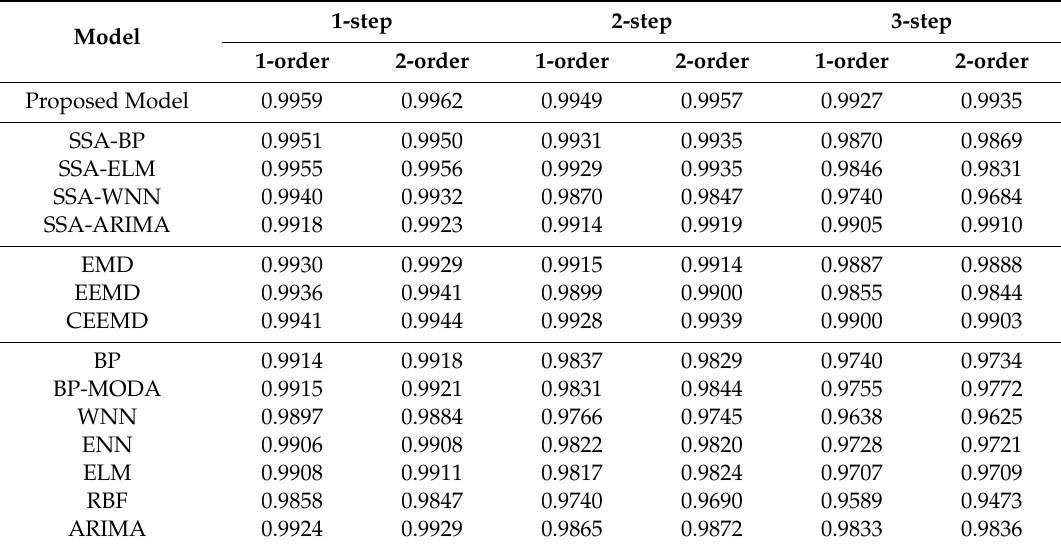
Table 9. Forecasting e ff ectiveness of di ff erent